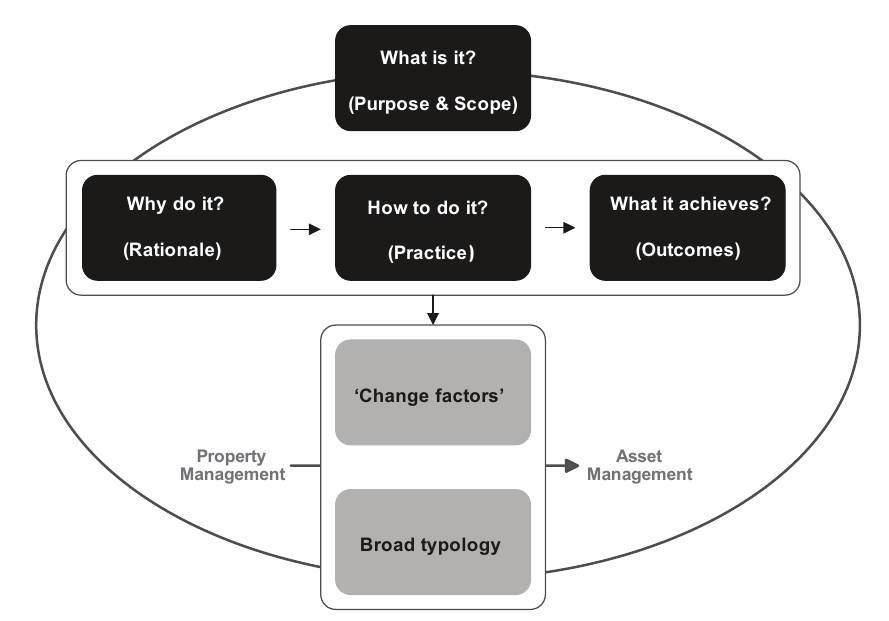
figure 2. The analytical